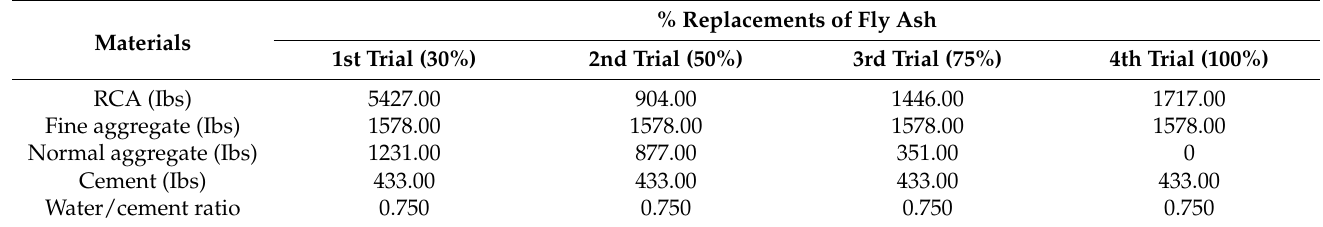
Table 4. Mix design.